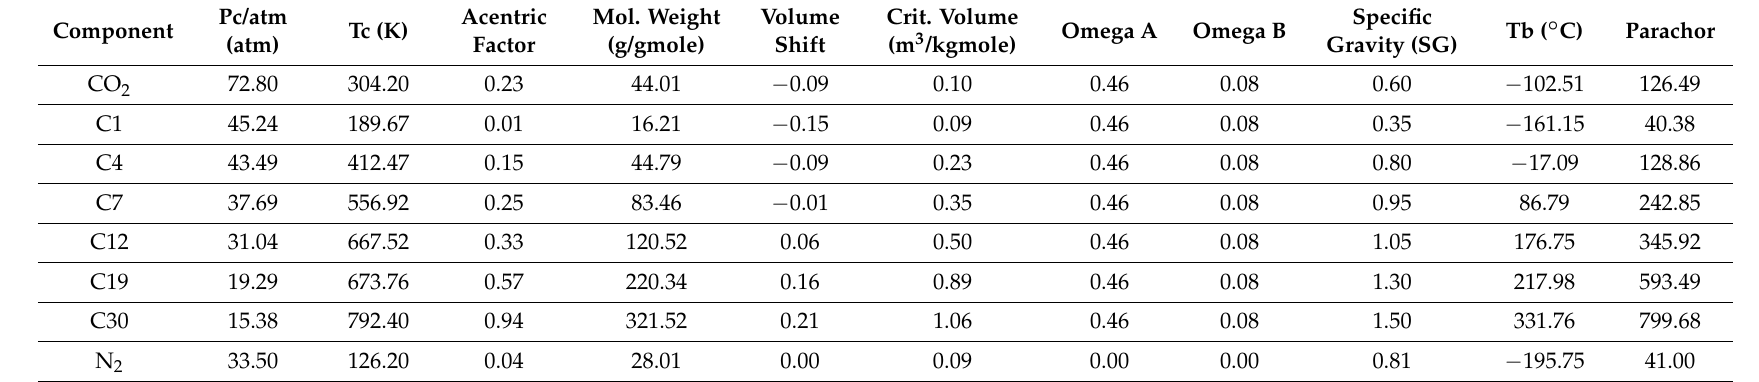
Table 4. Component properties and